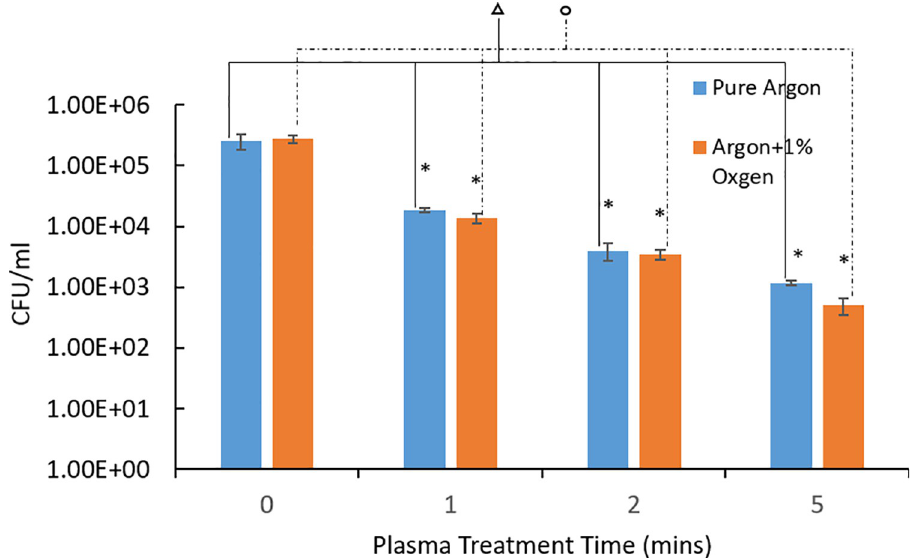
Fig 3. CFU counting results of plasma destruction of 3-day P . gingivalis biofilms after different plasma treatment times. Treatment time of 0 minutes represents the untreated control group. � denotes statistically significant difference compared with the control group with p < 0.05 according to ANOVA Tukey test. denotes the statistically significant differences among different treatment times of pure argon plasma with p < 0.05 according to ANOVA Tukey test. denotes the statistically significant differences among different treatment times of argon+1% oxygen plasma with p < 0.05 according to ANOVA Tukey test.